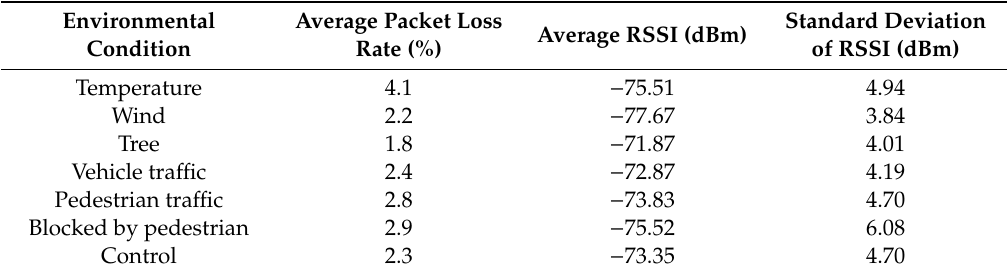
Table 1. Average packet loss rate, RSSI and standard deviation of